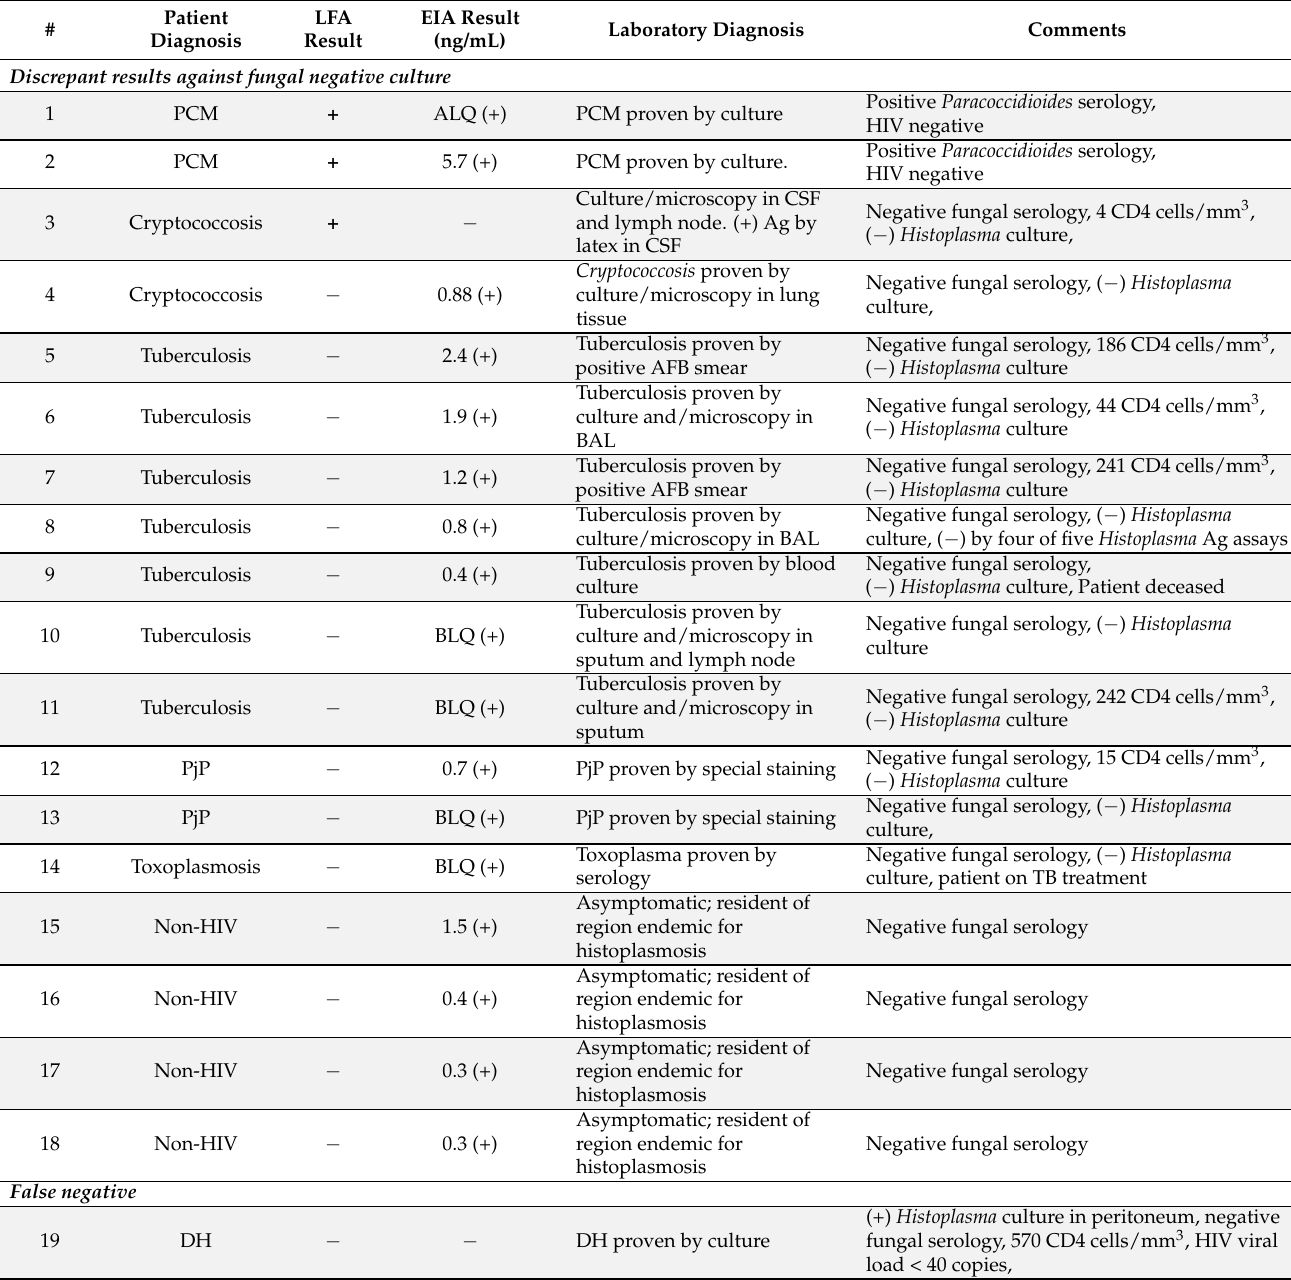
Table 2. Characteristics of patients’ specimens with results discrepant between culture/diagnosis and the MVD Histoplasma urinary Ag LFA and EIA.